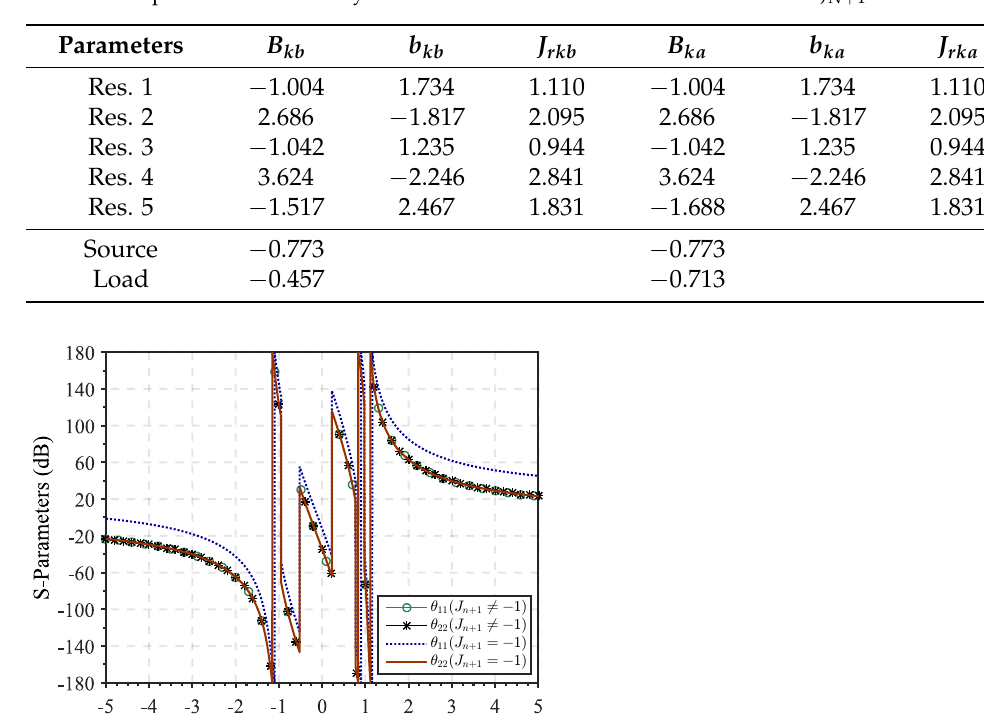
Table 8. Lowpass elements of the synthesized 5th-order ladder filter before and after J N + 1 redistribution.